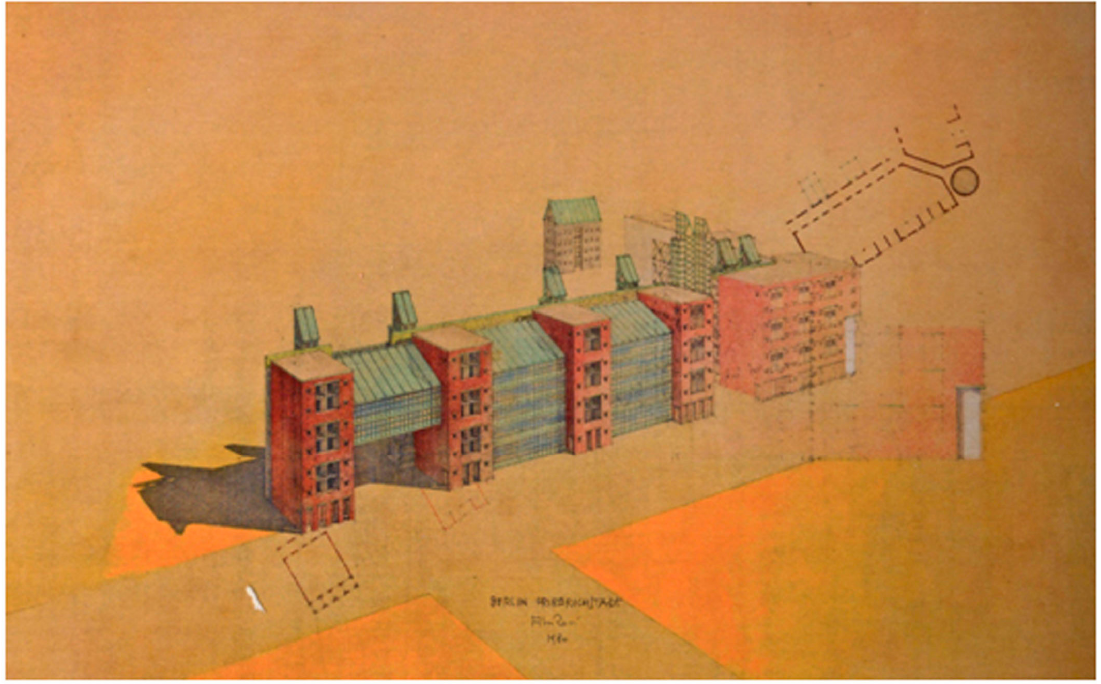
Figure 2. Aldo Rossi, plate for IBA 84. Plan and axonometry on Wilhelmstraße, Block 10,